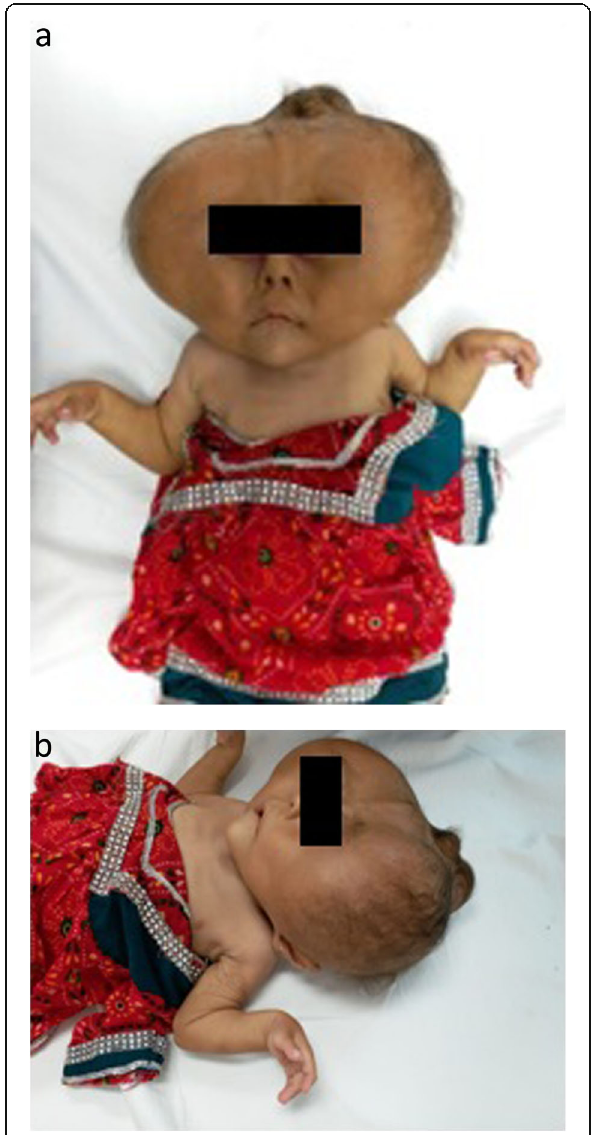
Fig. 1 a Patient with tri-lobar skull. b A side angle of the tri-lobar skull